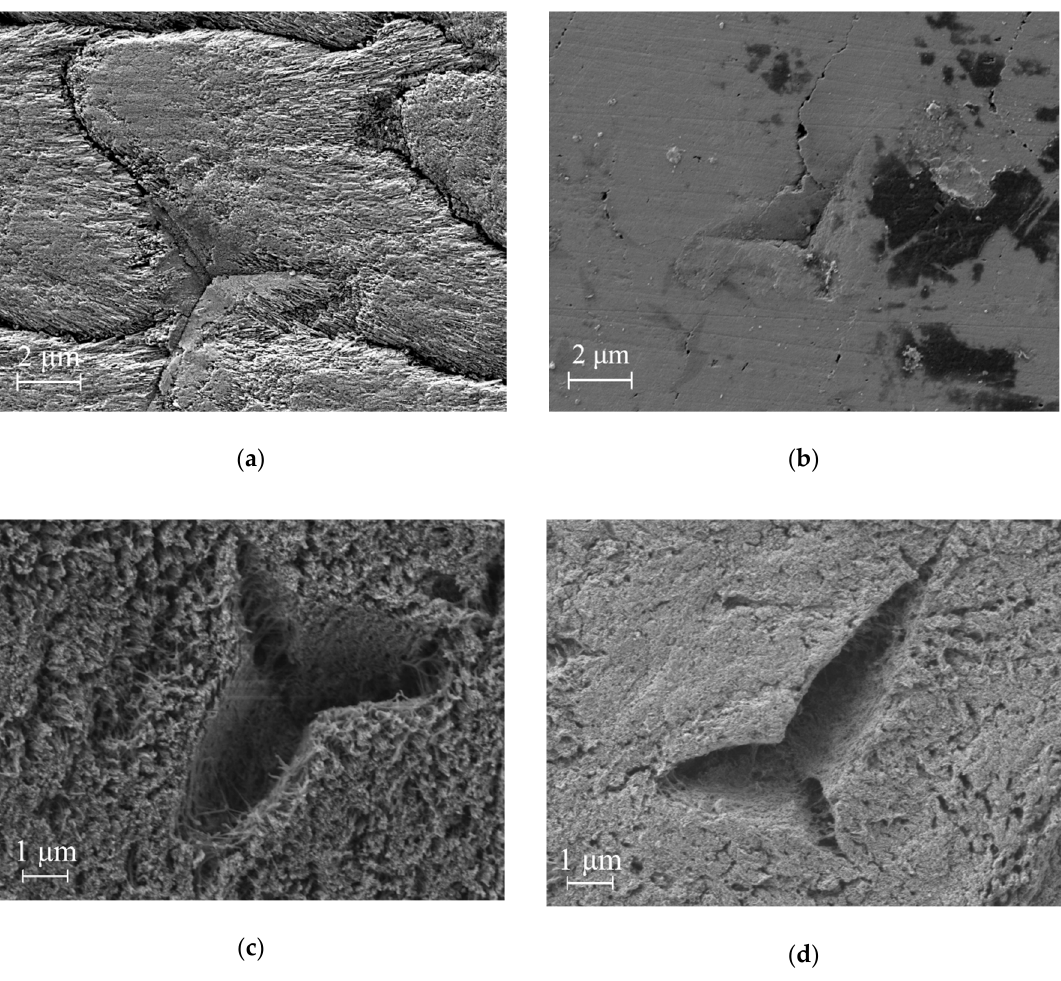
Figure 7. Surface and indenter impressions on the various tooth areas: ( a ) WSL, ( b ) area of sound enamel on the opposite medial side of the tooth, ( c ) dentine bordering the WSL, ( d ) dentine bordering the area of sound enamel. Note that for the sound areas study we rotated the sample 180º.